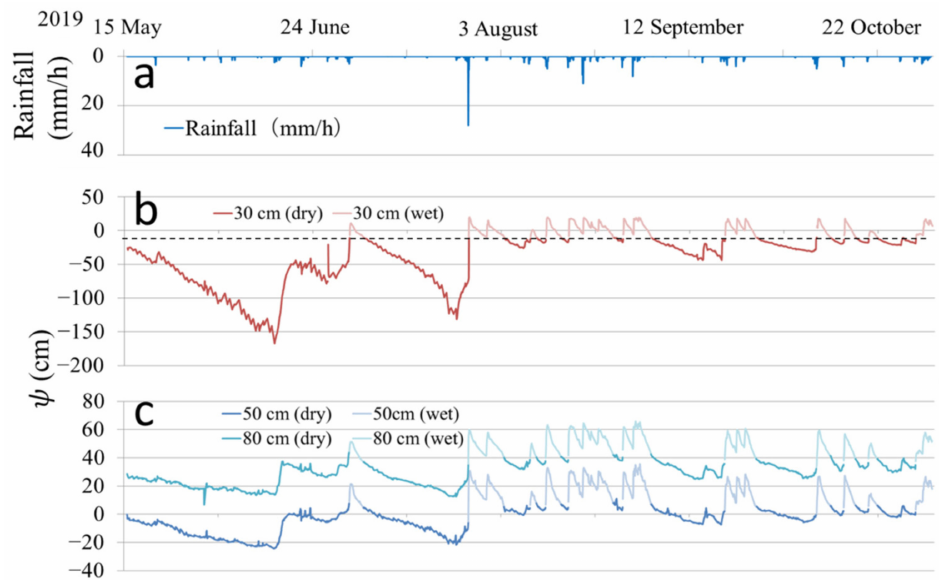
Figure 5. ( a ) Rainfall and ψ in the ( b ) OSLs (30 cm) and ( c ) CMLs (50 and 80 cm). Dashed line in panel ( b ) represents ψ = − 10